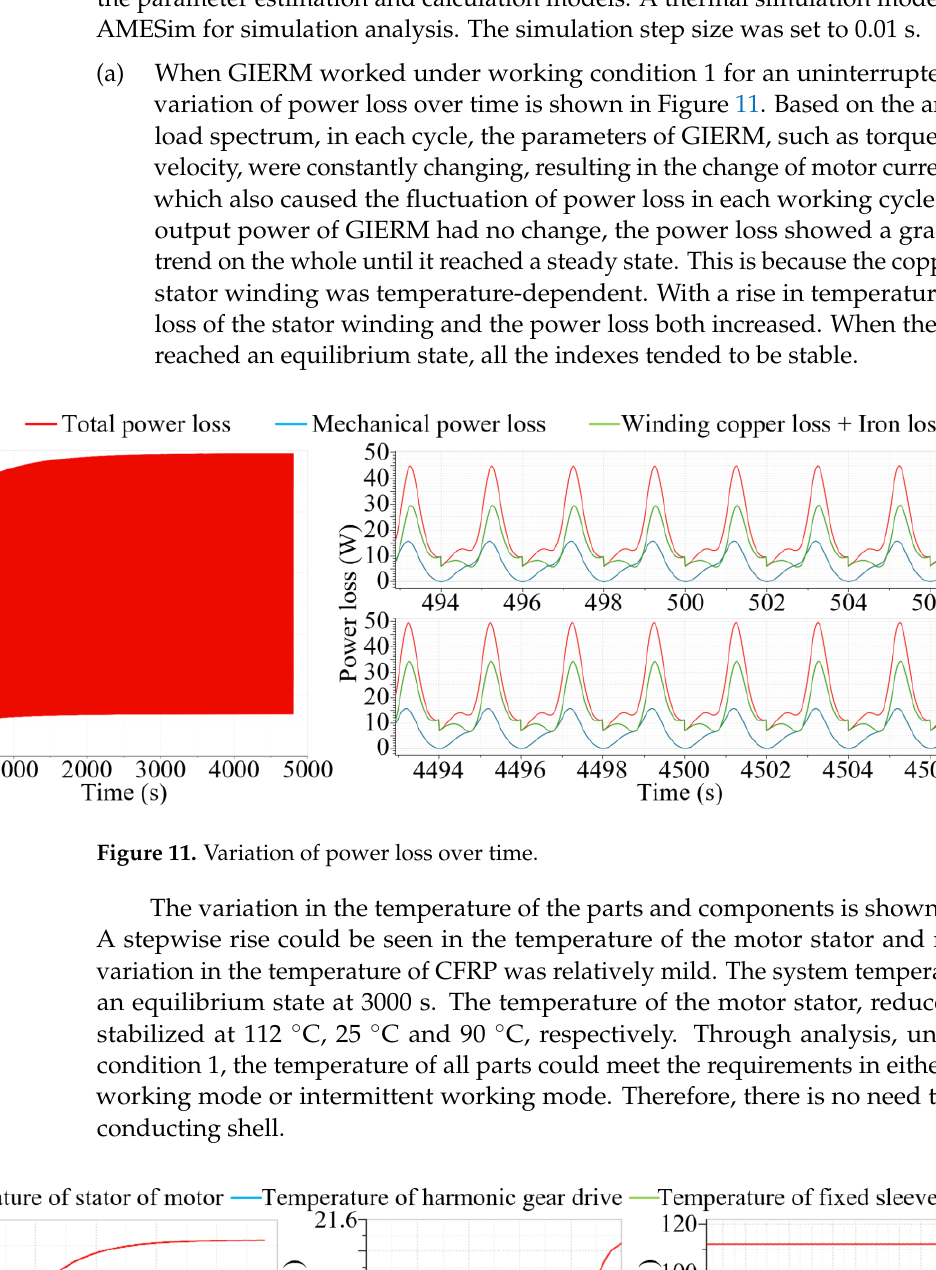
Figure 12. Variation of temperature of parts and components over time.